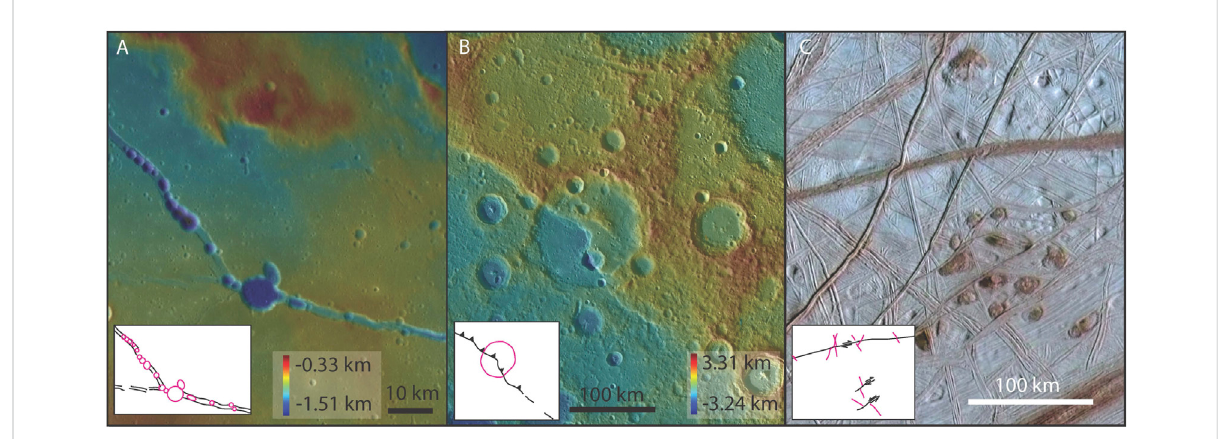
FIGURE 1 Imagery and simple maps of normal (A) , reverse (B) , and strike slip (C) planetary structures. The Rima Hyginus lunar graben system in (A) demonstrates the connection between pit volcanism and extension, with pit and fault traces in pink and black linework (Lunar Orbiter Laser Altimeter topography atop Lunar Reconnaissance Orbiter Camera Basemap near 5.8 ° E, 8.4 ° N). (B) Carnegie Rupes, a large thrust on Mercury, exempli fi eshowfaultsandcraterscaninteract(USGStopographyatopglobalmonochromemosaicnear68.9 ° W,58.2 ° N). (C) Strikeslipfaulting on Europa illustrates the tectonics of icey bodies (Galileo Orbiter imagery in the Northern